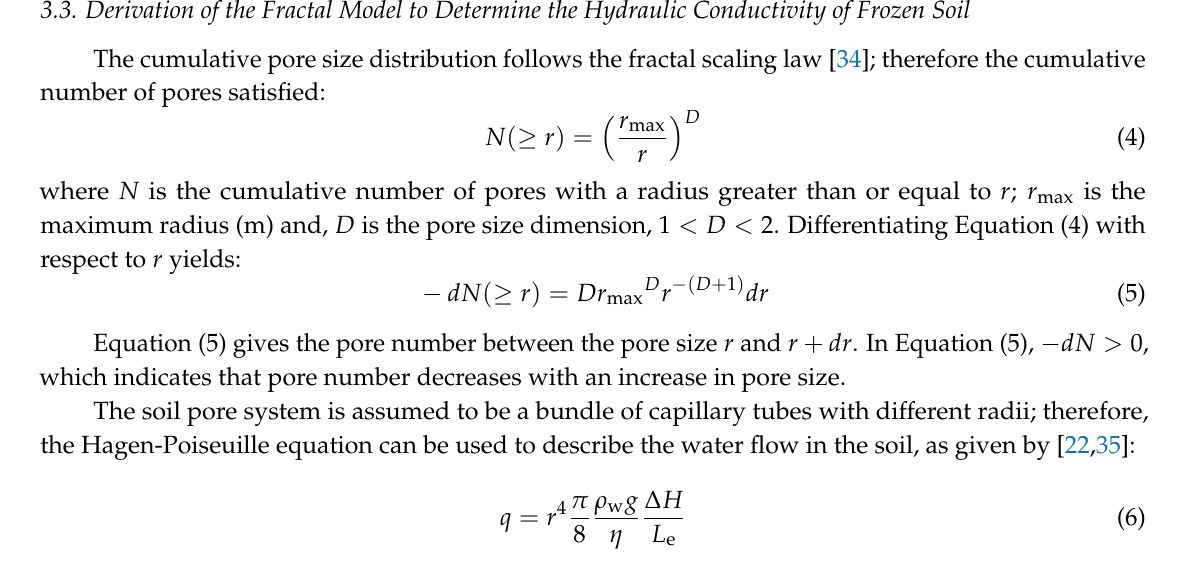
Figure 2. Schematic of freezing process of capillary tubes.